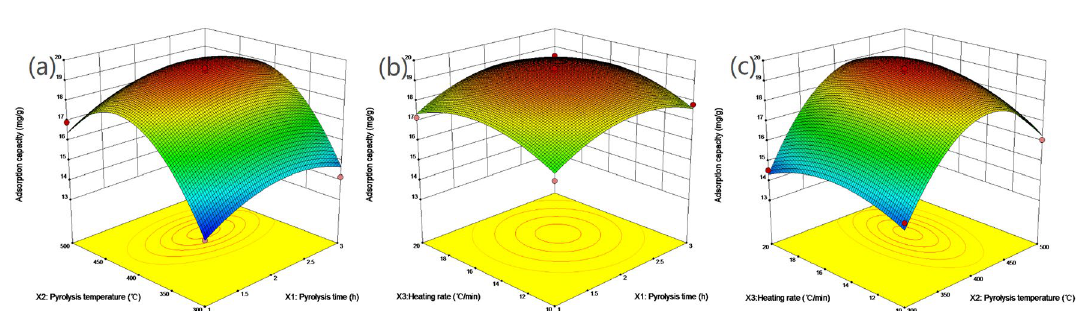
Figure 4. Three-dimensional (3D) plot of Zn 2+ adsorption capacity: ( a ) influence of pyrolysis time VS pyrolysis temperature, ( b ) influence of pyrolysis time VS heating rate, and ( c ) influence of pyrolysis temperature VS heating rate (Generated by Design-Expert 10.0, Stat-Ease. Inc., Minneapoils, MN, USA, https:// www. state ase.